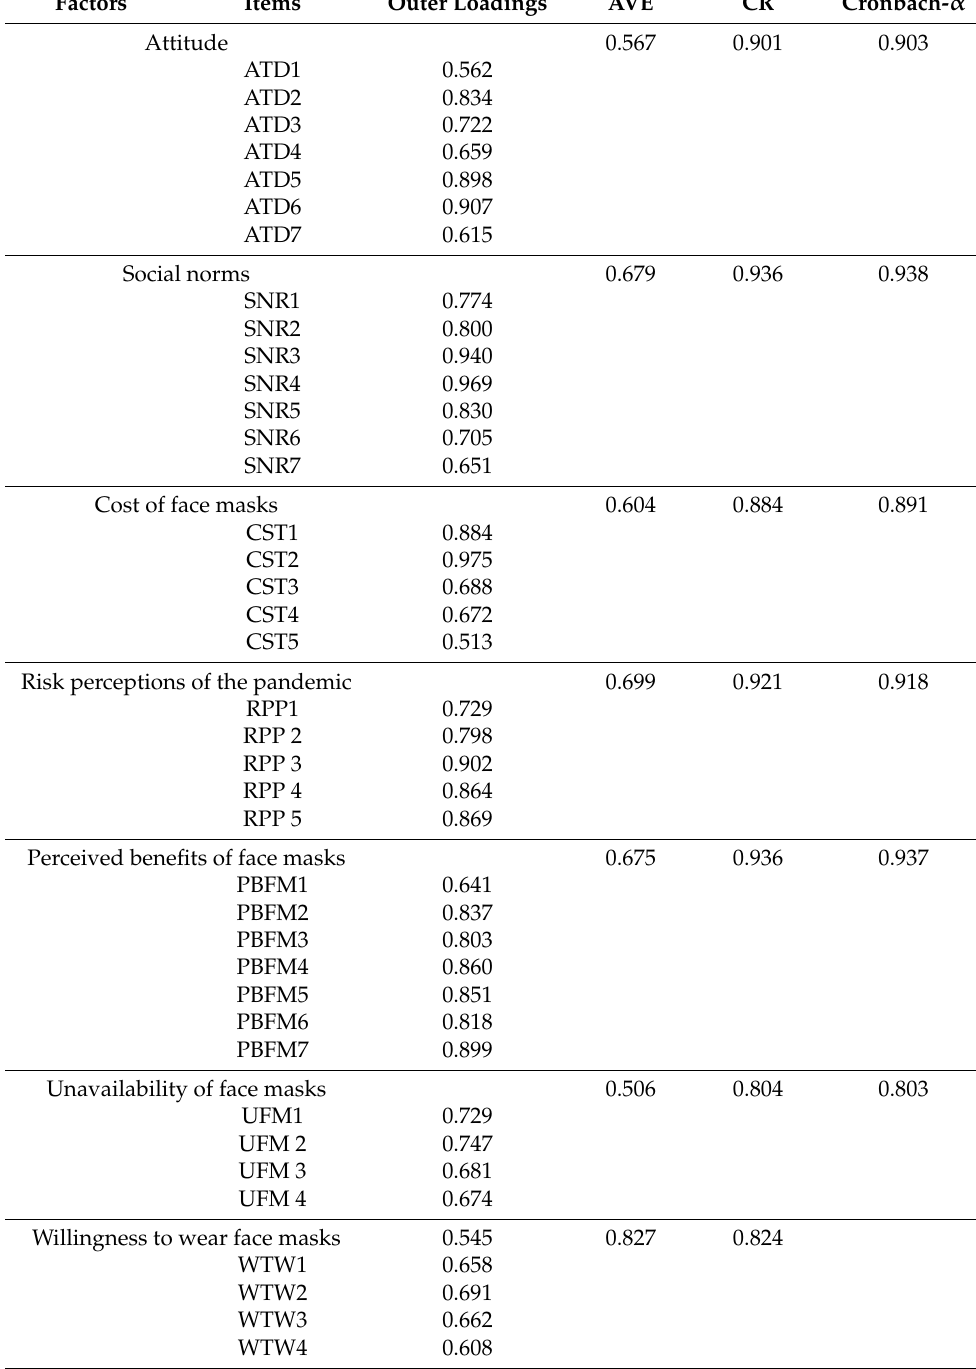
Table 4. Factor loadings and results of reliability, composite reliability, and convergent